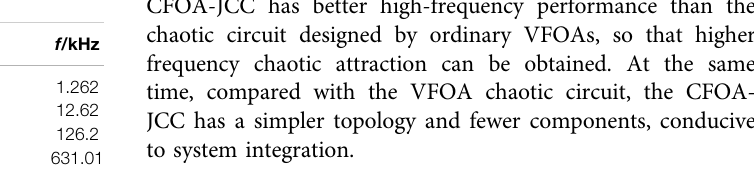
TABLE 2 | The theoretical values of f in deferent